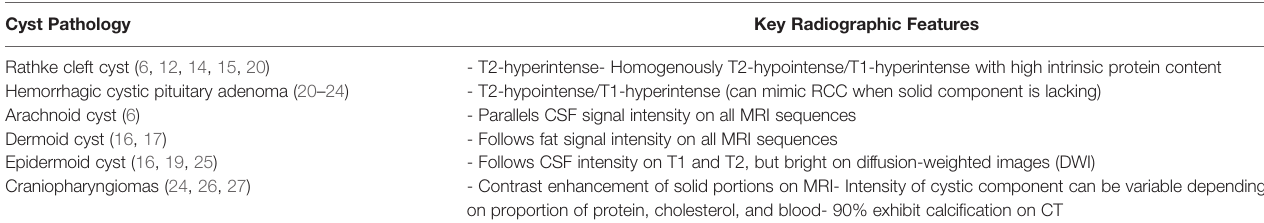
TABLE 4 | Key preoperative radiographic fi ndings for various cystic sellar pathology. Cyst